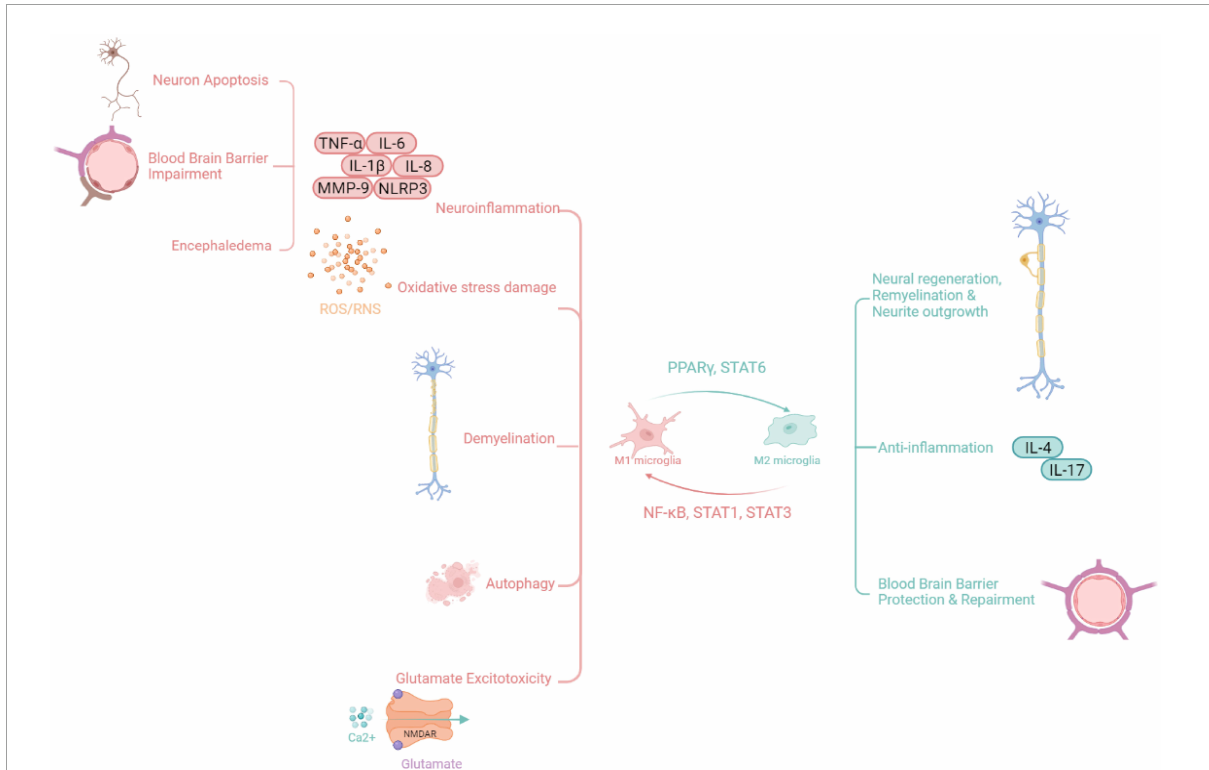
FIGURE1 Functions of microglia [Possible pathological mechanisms of M1 microglia after subarachnoid hemorrhage include oxidative stress, neuron apoptosis, autophagy, and immune inflammation. Microglia are also involved in the occurrence of brain edema, the processes of neuronal apoptosis, and the blood–brain barrier (BBB) disruption after subarachnoid hemorrhage (SAH) through inflammation response. Conversely, M2 microglia exert anti-inflammatory and protective